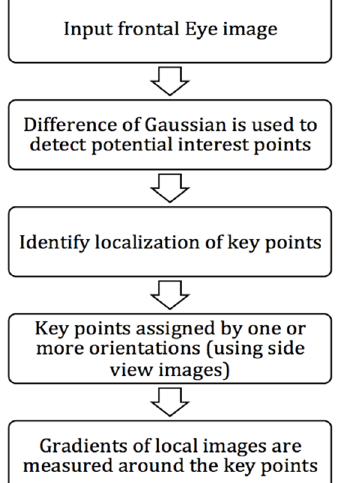
Figure 4. The stages of the feature extraction method.